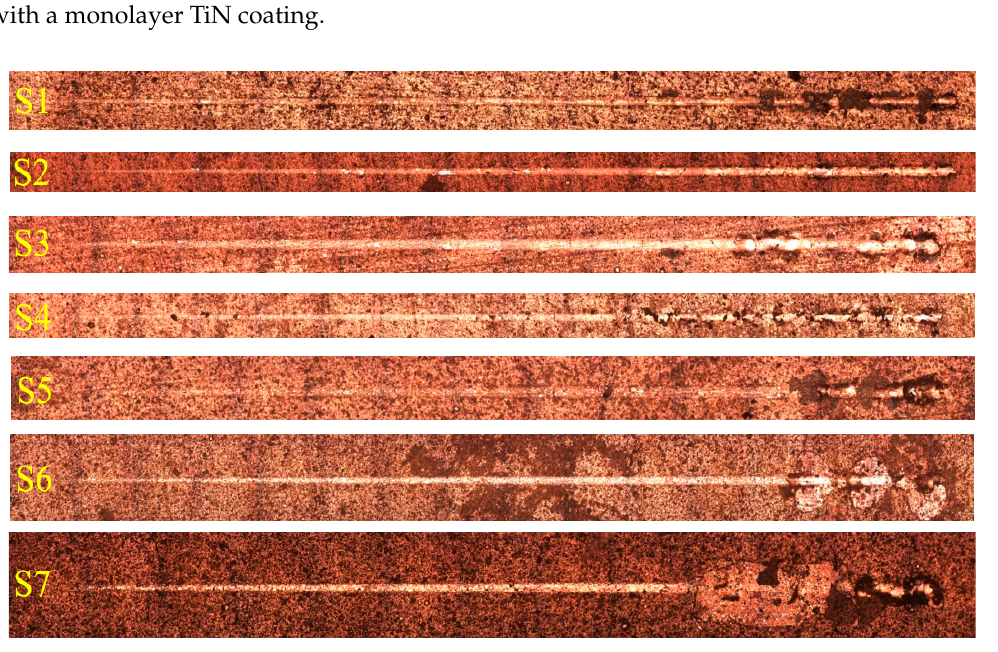
Figure 13. Scratch tests of the coatings under study.